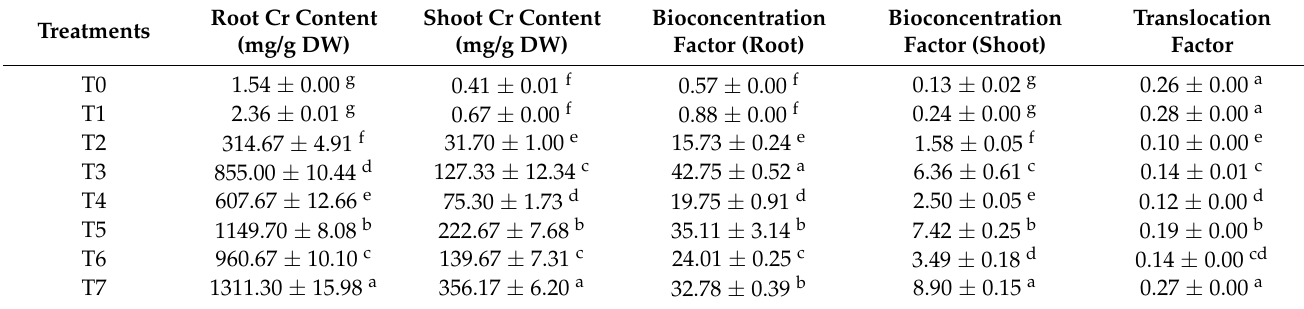
Table 6. Effect of chromium stress and B. cereus inoculation on chromium uptake, its bioconcentration, and translocation in B. nigra .